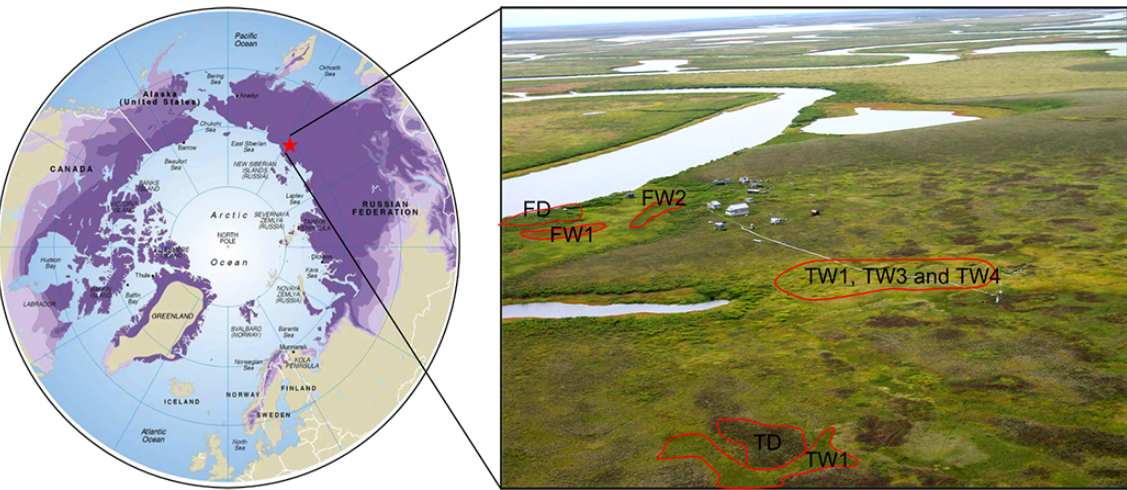
Figure 1. Location of the Kytalyk site and the distribution of different measurement groups. Left: Circumpolar permafrost map (Rekacewicz, 1998). Right: landscape of Kytalyk site (Van Huissteden et al.,